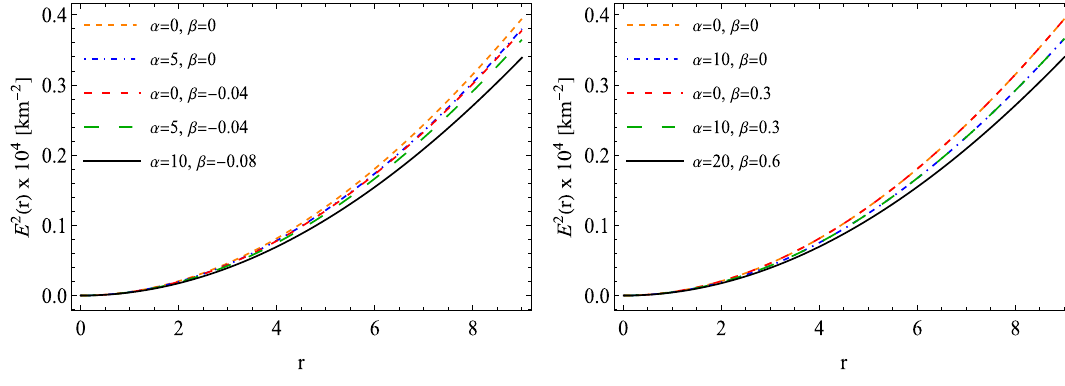
Fig. 6 The behavior of electric field ( E ) versus r for solution Sect. 3.1 (left panel) and solution Sect. 3.2 (right